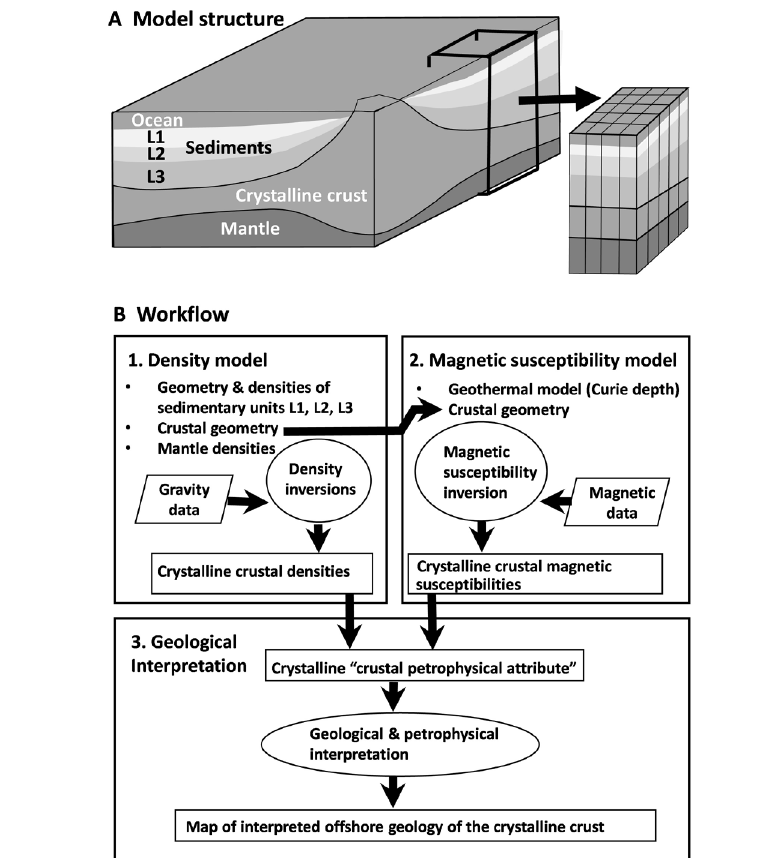
Figure 3. (A) Model structure for the gravity and magnetic field modelling and inversion. (B) Workflow for the development of the crustal petrology